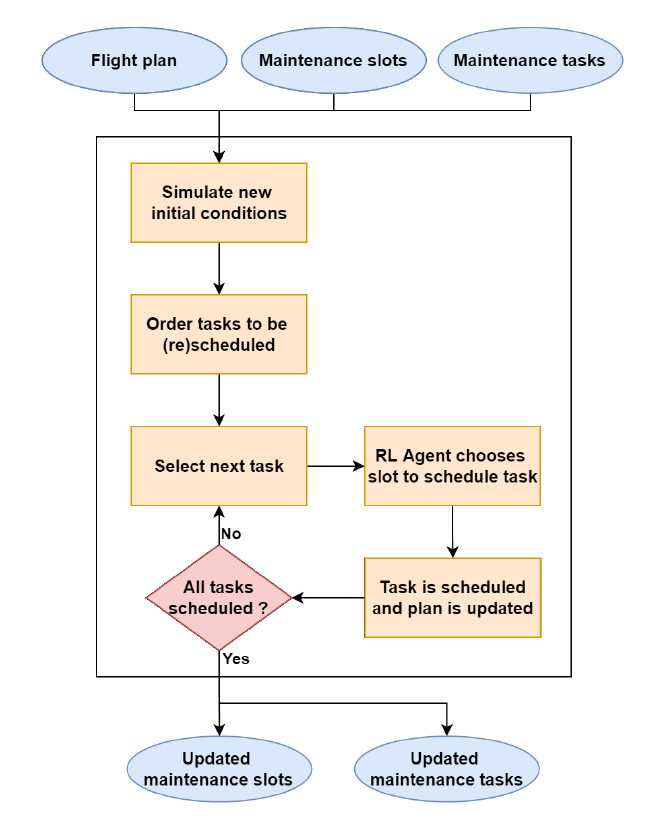
Figure 7. Activity diagram representing the automatic planning